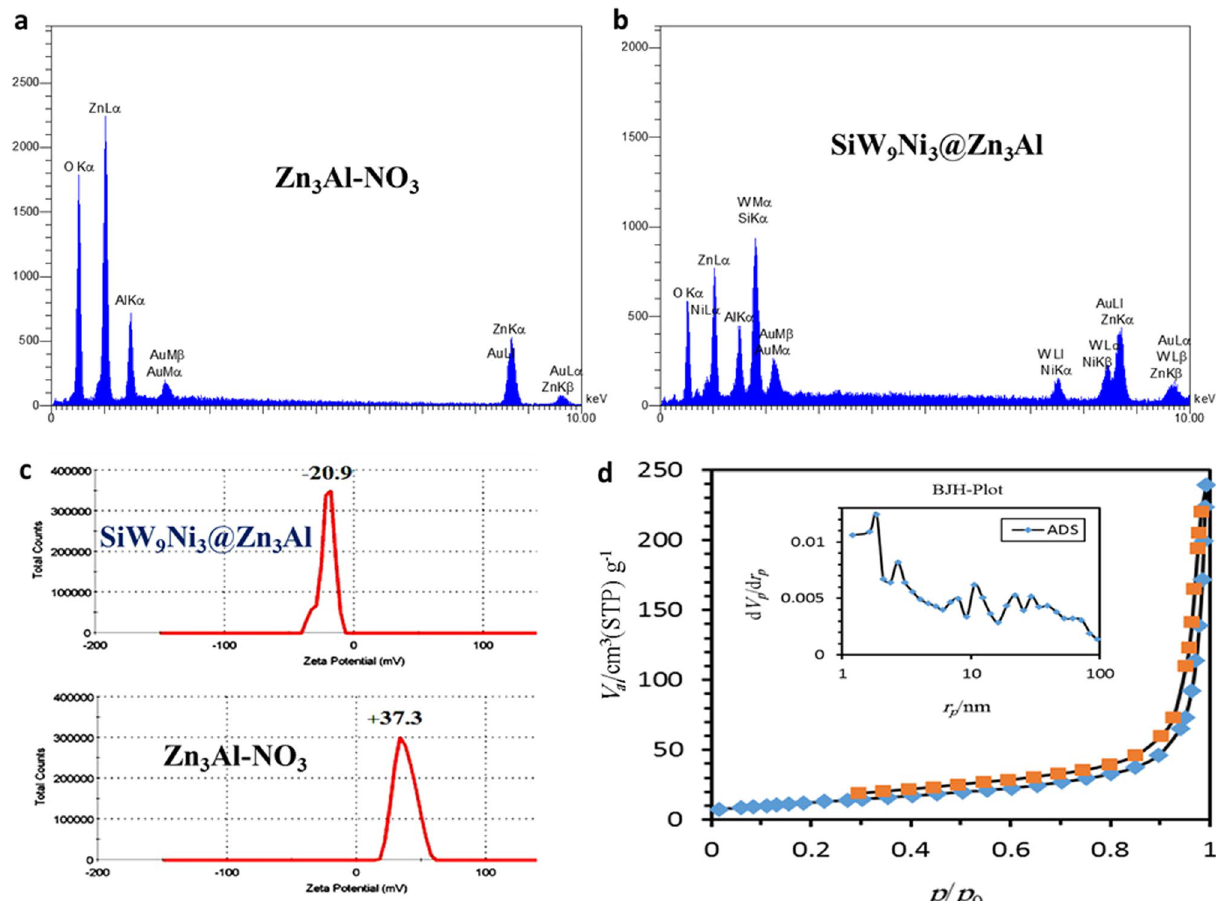
Figure 5. EDX patterns of ( a ) Zn 3 Al–NO 3 and ( b ) SiW 9 Ni 3 @Zn 3 Al; zeta-potentials of ( c ) Zn 3 Al–NO 3 and